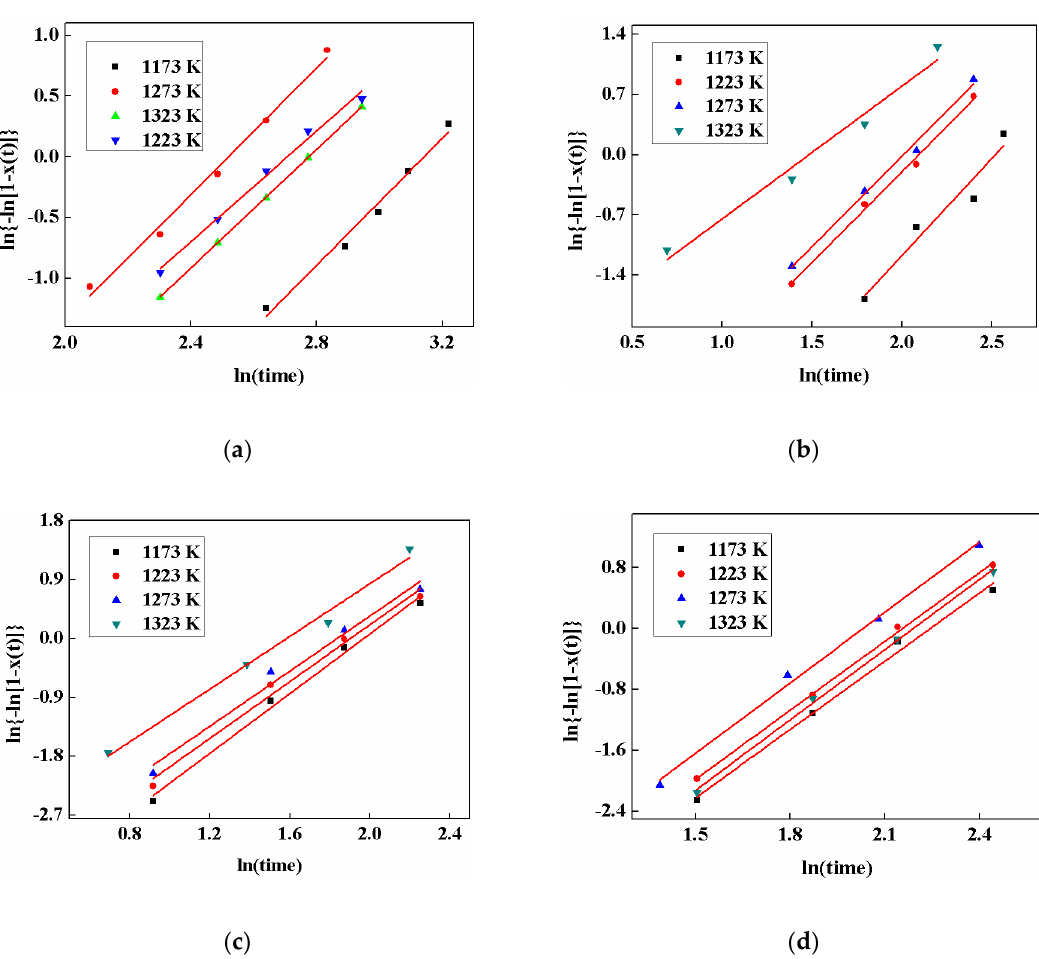
Figure 10. Plots of ln{ − ln[1 − X ( t )]} versus ln t for isothermal crystallization of the four series of mold fluxes ( a ) A, ( b ) B1, ( c ) B2, and ( d ) B3. Table 4. Results of n and k analyses for isothermal crystallization of mold fluxes under different temperatures.